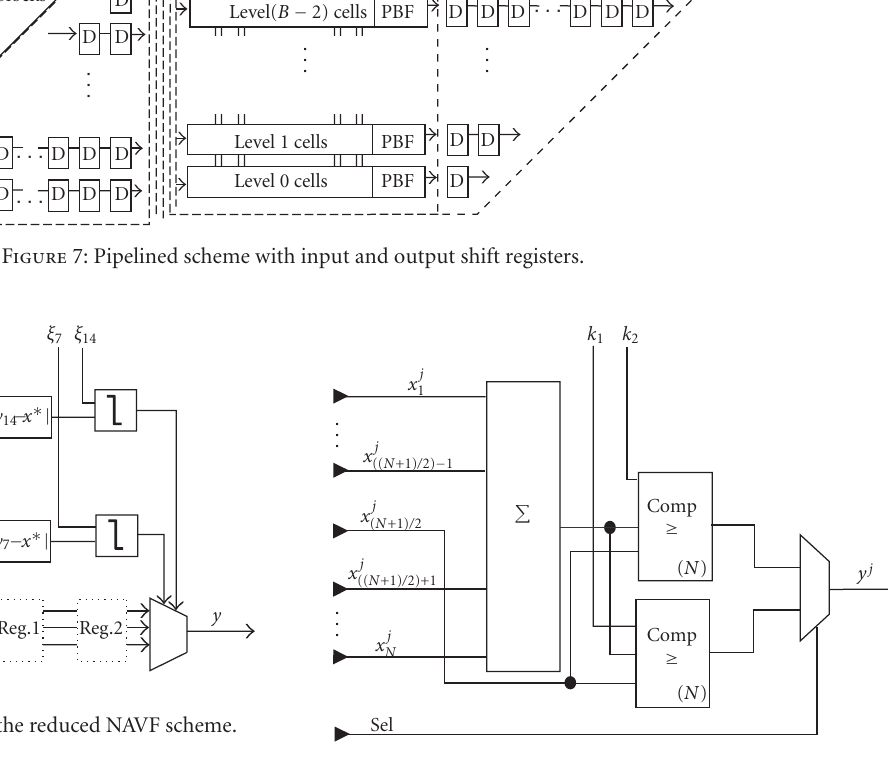
Figure 9: N -input double PBF function f k , N ( · ) internal